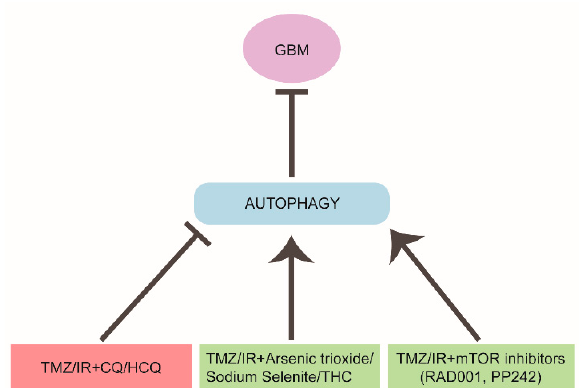
Figure 2. Targeting autophagy in GBM therapy. The effects of different therapeutic combinations on autophagy and the outcome on GBM progression in patients are shown. Chloroquine or hydroxy-chloroquine (CQ/HCQ) addition to standard protocols (TMZ/IR, temozolomide/radiation therapy) impairs the autophagy flux and sensitizes GBM to the treatment (pink box). Otherwise, several chemical compounds and mTOR inhibitors, that are able to stimulate autophagy, also increase the efficacy of the standard treatments (green boxes). THC, tetrahydrocannabinol.